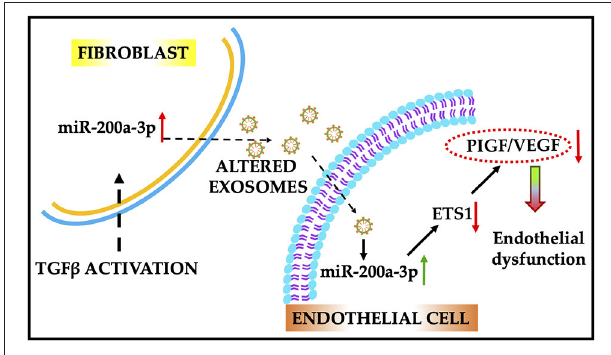
FIGURE 9 | Schematic illustration of the proposed role of miR-200a-3p/ETS1/VEGF-A signaling cascade in endothelial dysfunction. Activated fibroblast-derived exosomes enriched with miR-200a-3p induce endothelial dysfunction by altering the VEGF-A/PIGF signaling. Alteration in miR-200a-3p expression using antimir therapy improved endothelial cell function. ETS1, E26 transformation-specific sequence factor-1; VEGF-A, vascular endothelial growth factor-A; PIGF, placental growth